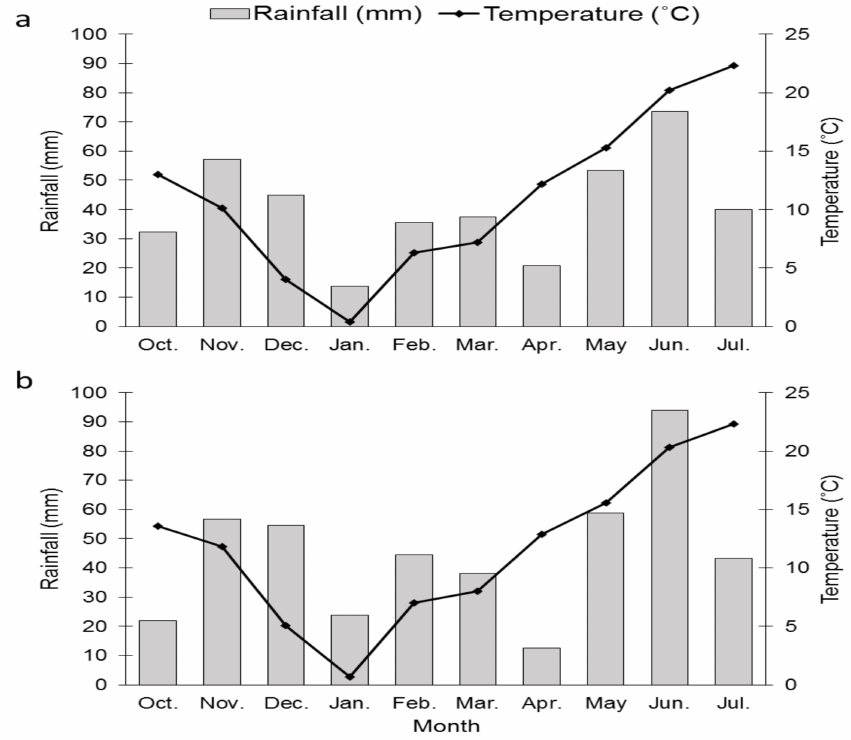
Figure 1. Climate diagrams for vegetative season 2019/2020 at Osijek ( a ) and Tovarnik ( b ),